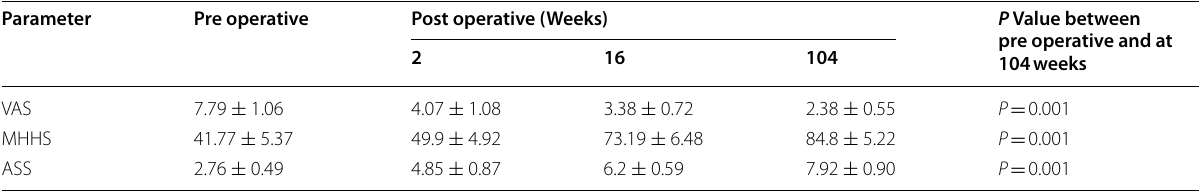
Table 2 Assessment of Pre and Post ABMDO Transplantation